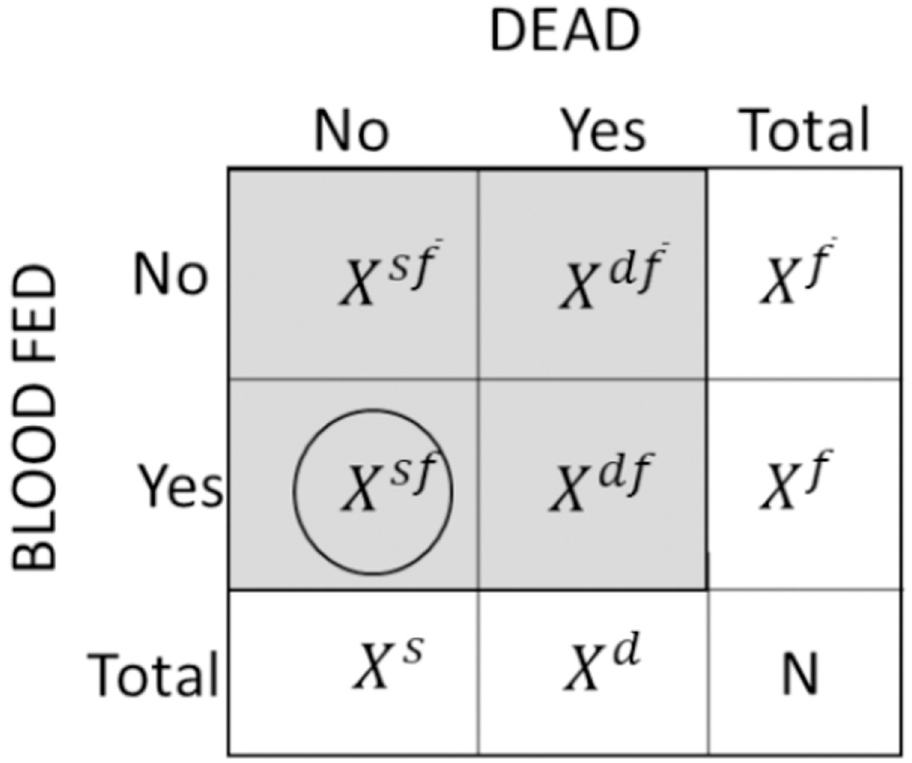
Fig 1. Contingency tables of trial data. The number of mosquitoes that are blood-fed ( X f ) and the number of mosquitoes that are killed ( X d ) are known for both data sources but, for the aggregated data we do not know directly the number of mosquitoes that are both alive and blood-fed ( X sf ) (circled). We have the full complement of data from the comprehensive source.